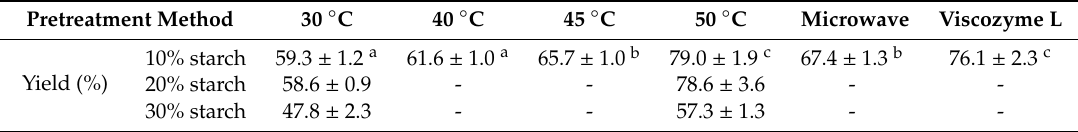
Figure 1. Evolution of produced glucose as a function of hydrolysis time (symbols were experimental data; dotted lines were obtained by regression analysis fitted with Equation (3), 10% w / w of starch i.e., 14.3% dry matter). Table 1. Hydrolysis yield after 48 h of